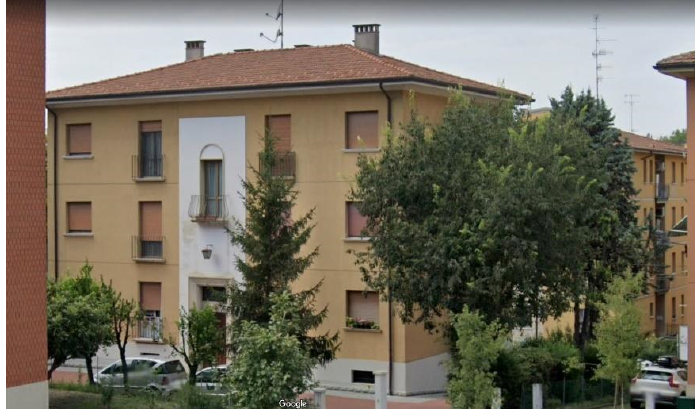
Figure 6. External view of the building (from Google Maps–Street View).